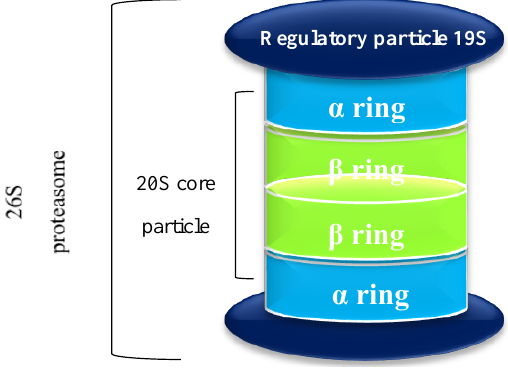
Figure 1. The 26S proteasome schematic representation.